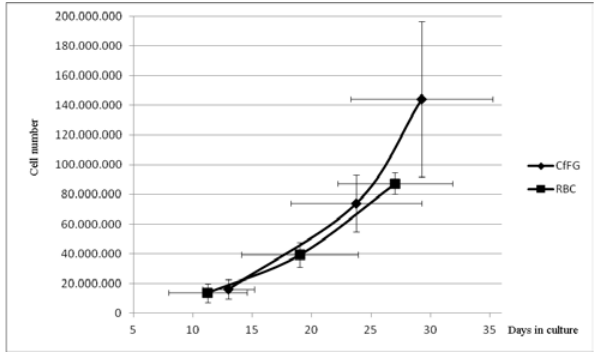
Figure 1: MSCs amount obtained at different passages (P0, P1, P2) using centrifugation through ficoll gradient (CfFG) and red blood cell (RBC) lysis methods. Results are expressed as mean values ±